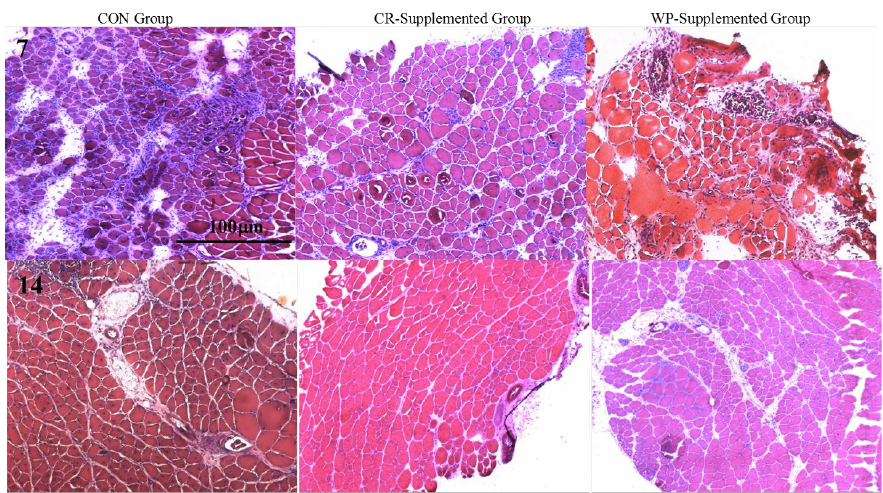
Figure 3. Hematoxylin and eosin-stained sections of injured EDL muscles from rats treated with standard rat chow- (CON-), whey protein- (WP-), or creatine- (CR-) supplemented rat chow at 7 and 14 days post-injury. Scale applies to all panels.